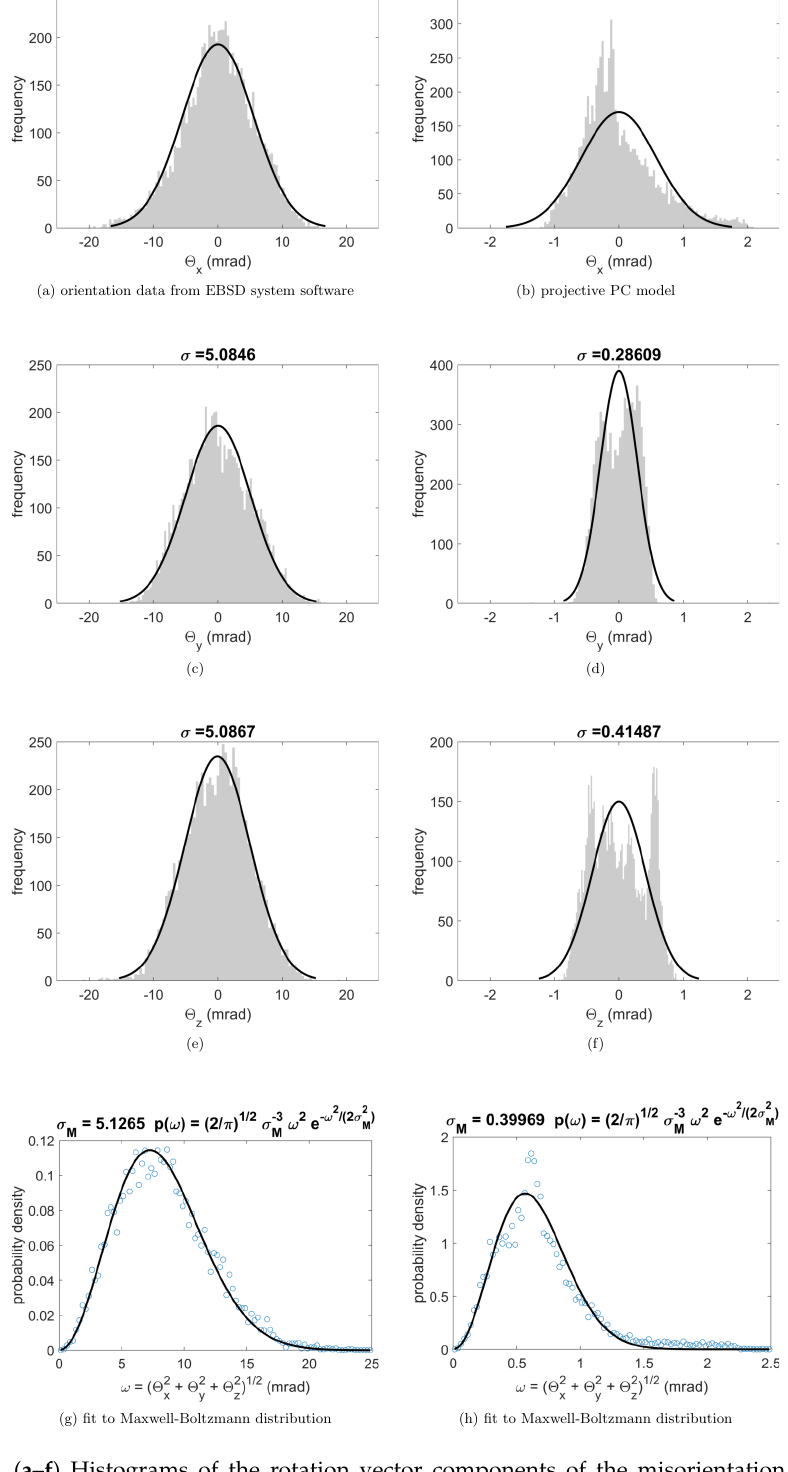
Figure 6. ( a – f ) Histograms of the rotation vector components of the misorientation relative to the mean orientation, ( a , b ) Θ x , ( c , d ) Θ y , ( e , f ) Θ z ; and ( g , h ) the histograms of the misorientation angles ω . The black solid lines correspond to fits of Gaussian distributions (top three rows) and Maxwell–Boltzmann distributions (lower row) with the standard deviations shown on top of each plot. The left column shows the data for the raw EBSD maps, the right column shows the results from the orientation data which was refined by the projective model. Note that the angular scale for the left column is ten times larger than for the right